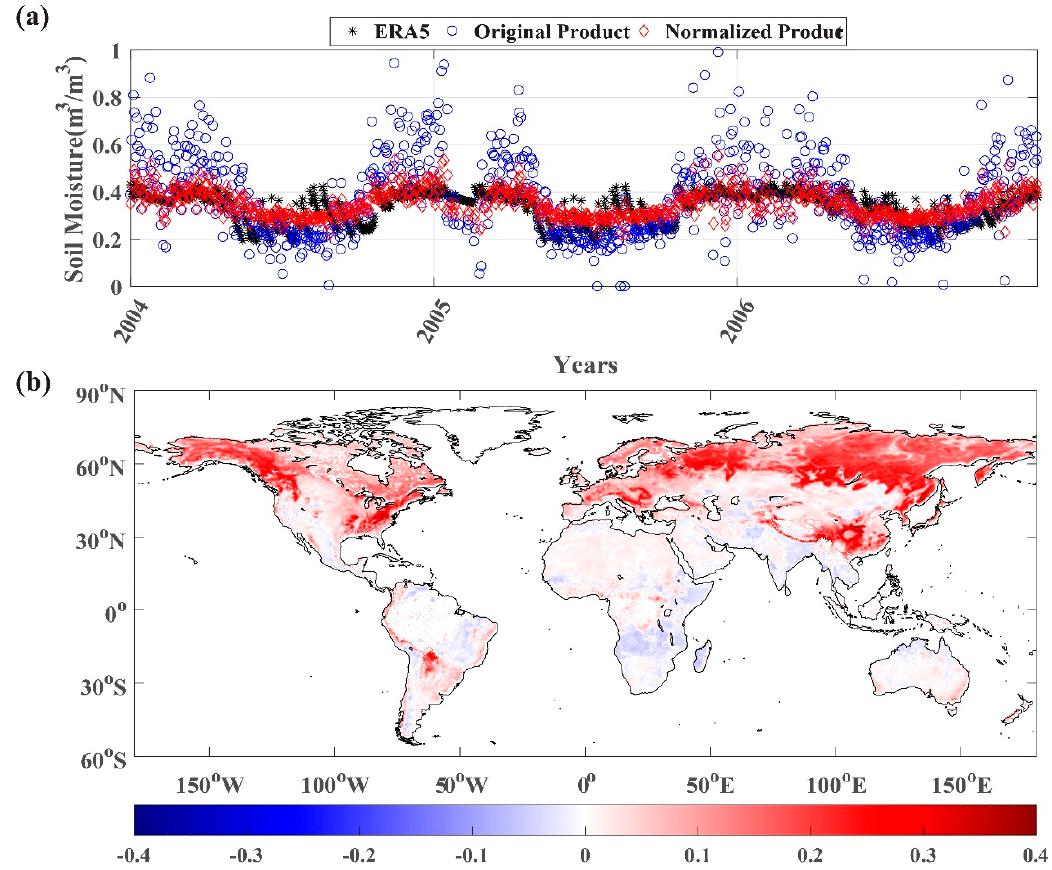
Figure 2. ( a ) Comparison of a selected time–series (LON: 81.25°E, LAT: 40.65°N) to investigate the impact of the normalization process on the satellite products. Here, the time series is chosen from AMSR-E; ( b ) difference between standard deviations of the original advanced microwave scanning radiometer-earth observing system (AMSR-E) and normalized AMSR-E global soil moisture observations. Red color shows higher values in the original product and blue color shows higher amplitudes in the normalized product.